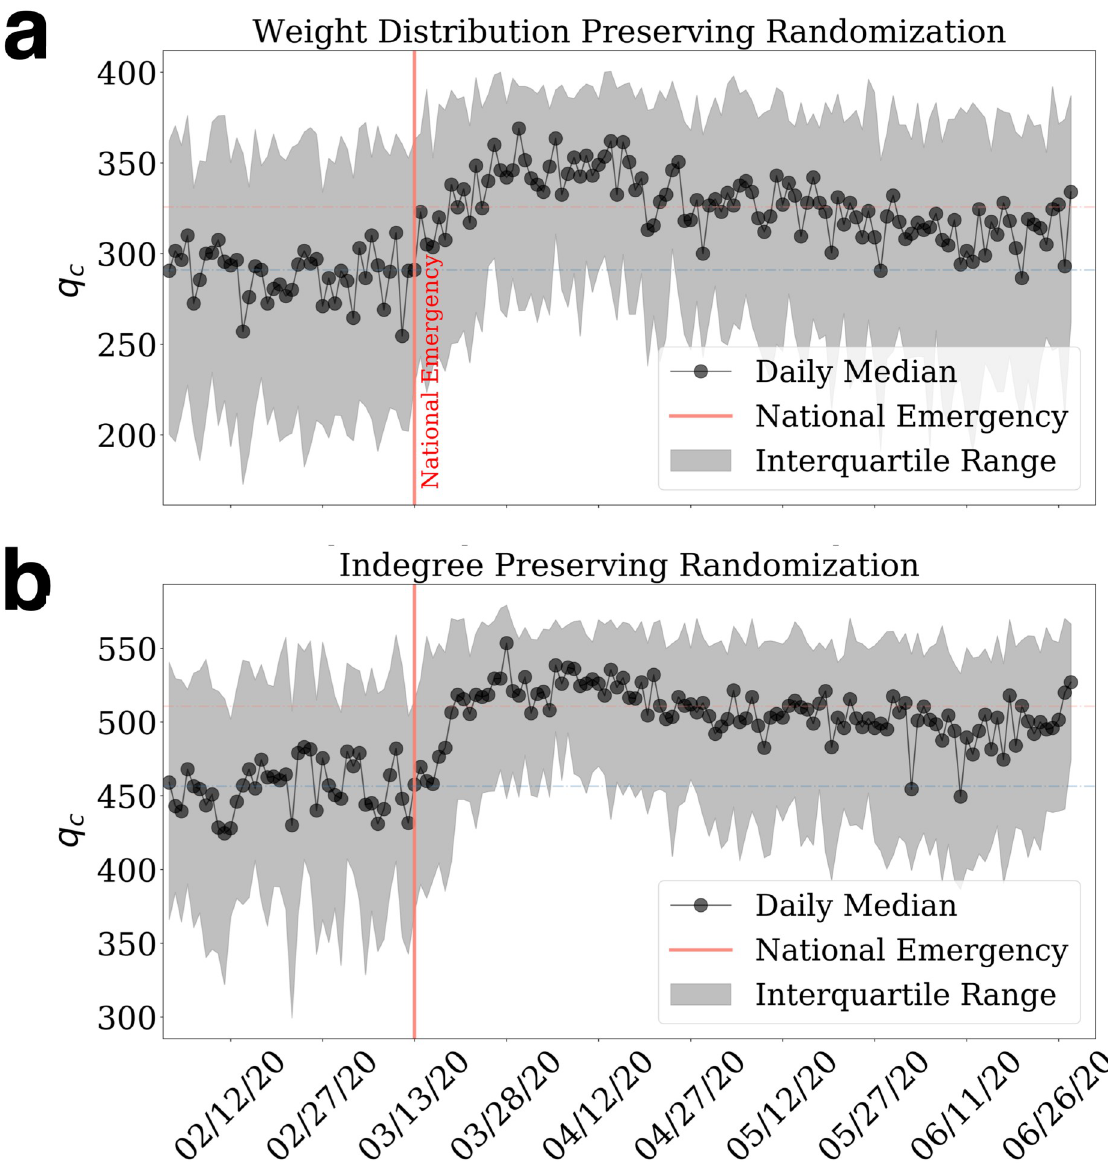
Fig 7. Temporal changes of randomized percolation metrics. a , the distribution of daily q preserve network’s weights. b , the distribution of daily q c from 1,000 iterations of randomization that preserve the indegrees of the network. The black dots represent the daily median value and the shaded areas indicate the interquartile range (IQR).